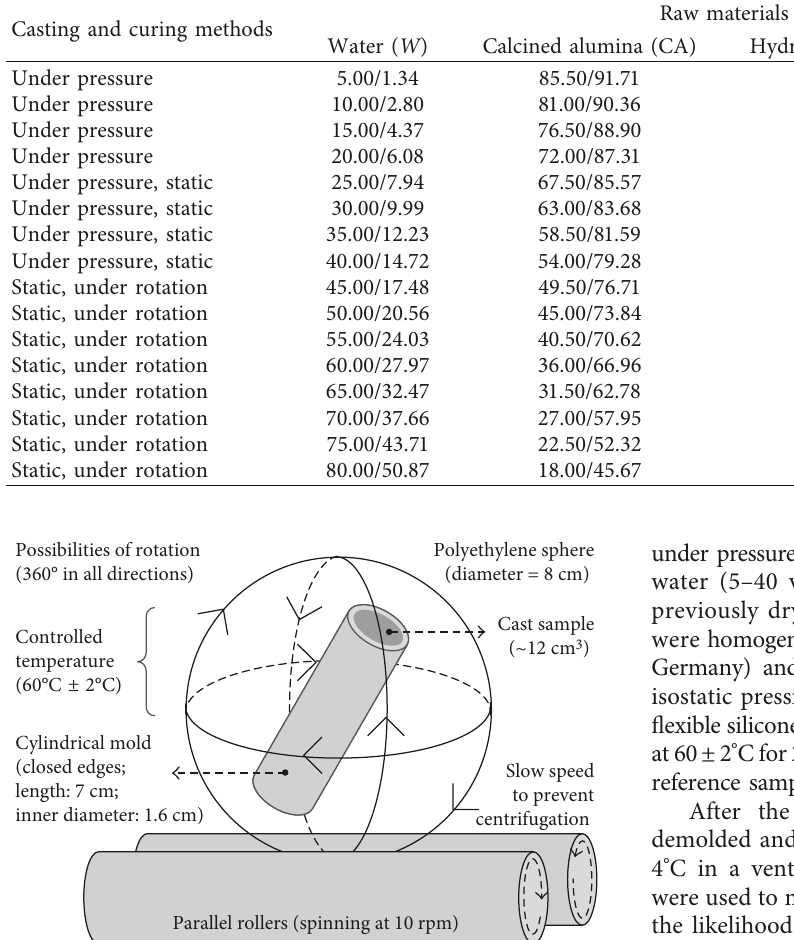
Figure 2: Rotating device used to prevent particle sedimentation during the curing step of very low solid-load